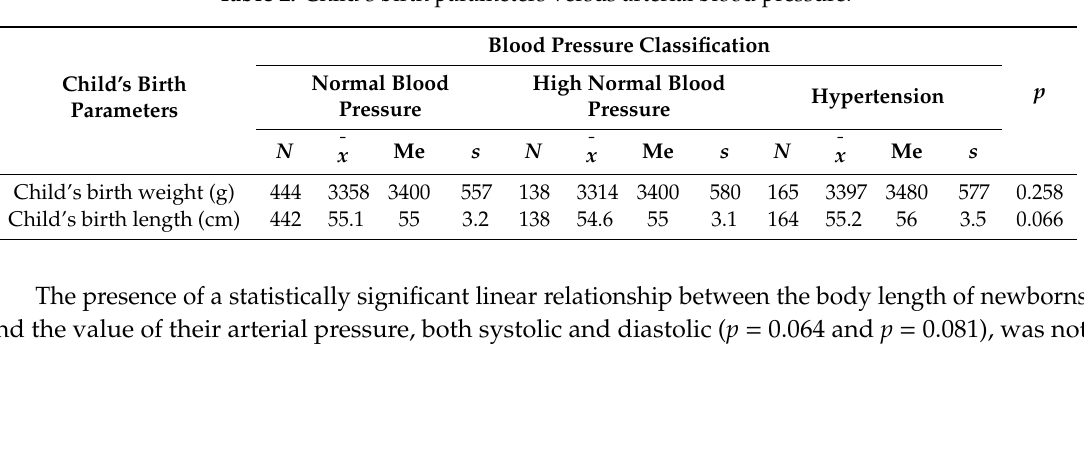
Table 2. Child’s birth parameters versus arterial blood